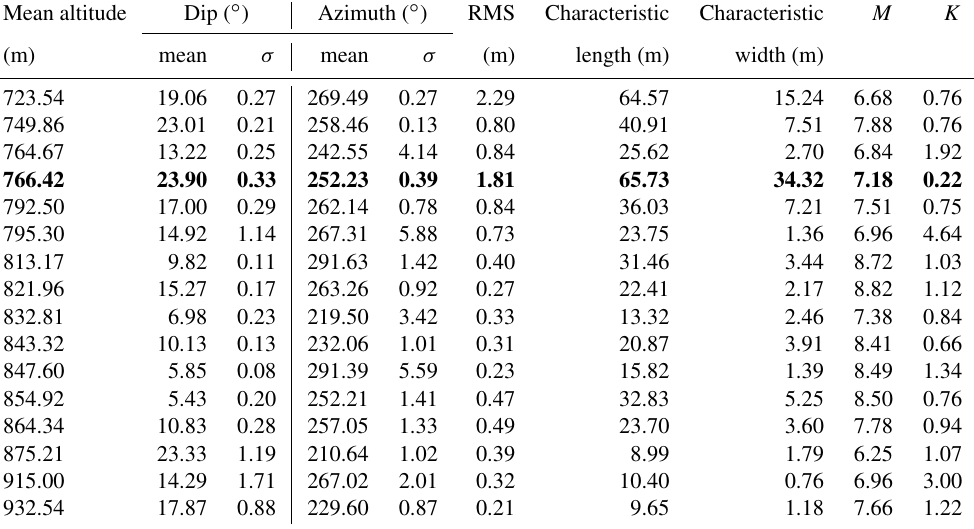
Table A1. Deposition horizon characterization. σ is the standard deviation of estimated dip and dip directions. See Appendix A for char- acteristic length and width computations, as well as for the derivation of M and K . Following Fernández (2005), a good fit and reliability correspond to M ≥ 4 and K ≤ 0 . 8. The line in bold corresponds to the plane fitted to the contact S 0 between LPd and UPd (red line and dot in Fig.